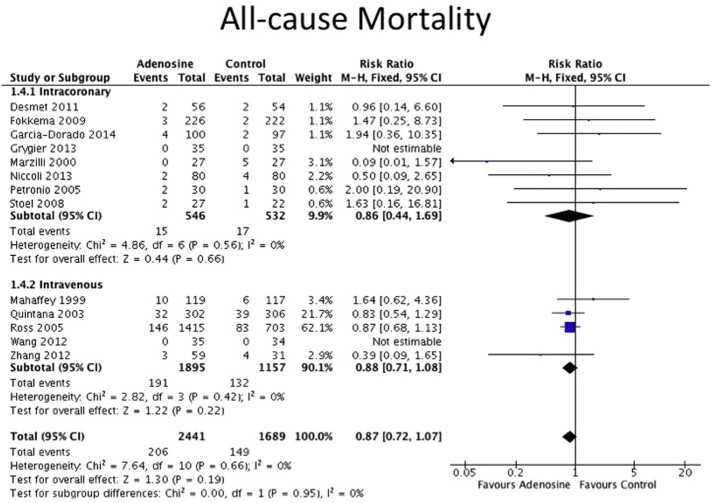
Forest plot for all-cause mortality, adenosine v control.